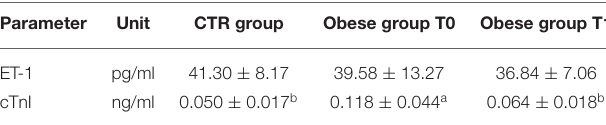
Data are expressed as mean ± standard mean error. Along the row, different letters are used to indicate significant differences between groups at p < 0.05. ET-1, endothelin-1; cTnI, cardiac troponin